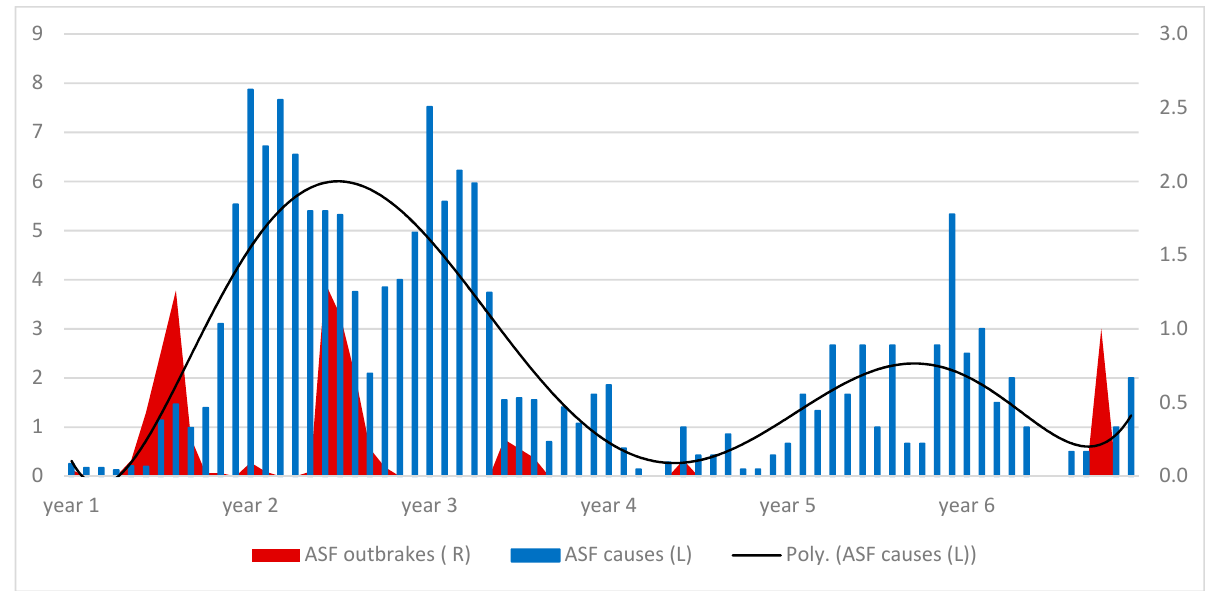
Figure 3. ASF life cycle based on the average of 1-year onset of disease. Source: own study based on CVI and PKO BP data. Explanation: the figures in the graph are the arithmetic means for ASF outbreaks in domestic pigs and for ASF outbreaks in wild boars in the following months.